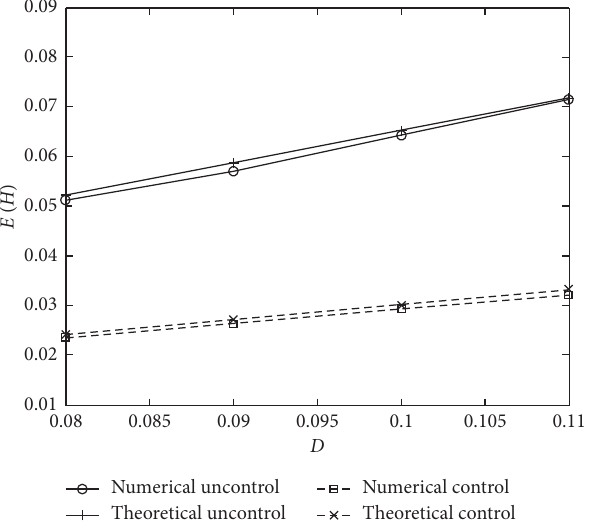
of system (10) as function of D 1